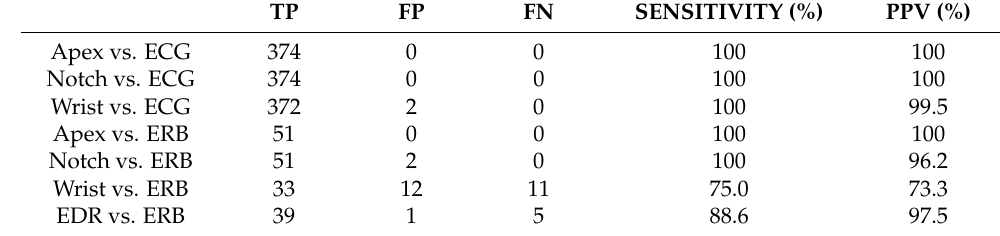
Table 1. Statistics for peak detection in heart and respiration monitoring signals.